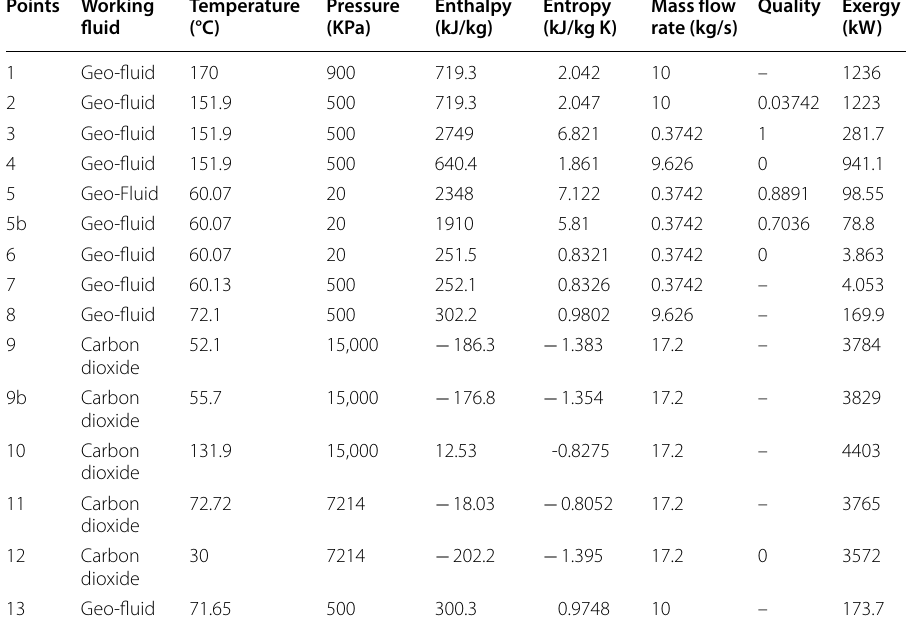
Table 3 Thermodynamic properties of the single flash geothermal power plant combined with the trans-critical CO cycle 2